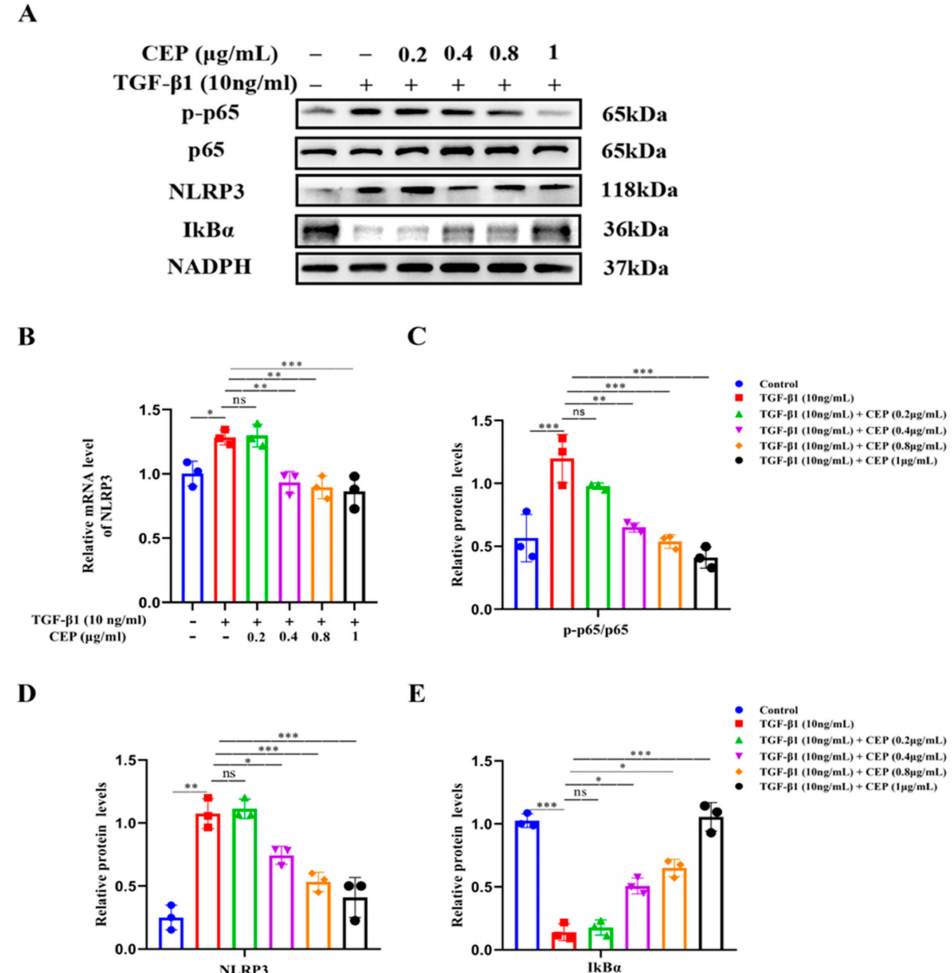
Figure 4. CEP suppressed TGF- β 1-induced inflammation via the NF- κ B/NLRP3 pathway in vitro. ( A ): Protein levels of NLRP3, phosphorylated p65 (p-p65), p65, and I κ B α measured with Western blotting, respectively. ( B ): mRNA levels of NLRP3 measured with RT-qPCR. ( C ): The ratio of the amount of protein level in p-p65/p65 with gray value and Image J software was used. ( D ): NLRP3 protein level was quantified by grayscale value and Image J software was used. ( E ): I κ B α protein level was quantified by grayscale value and Image J software was used. ns: no statistical difference, * p < 0.05, ** p < 0.01, and *** p <